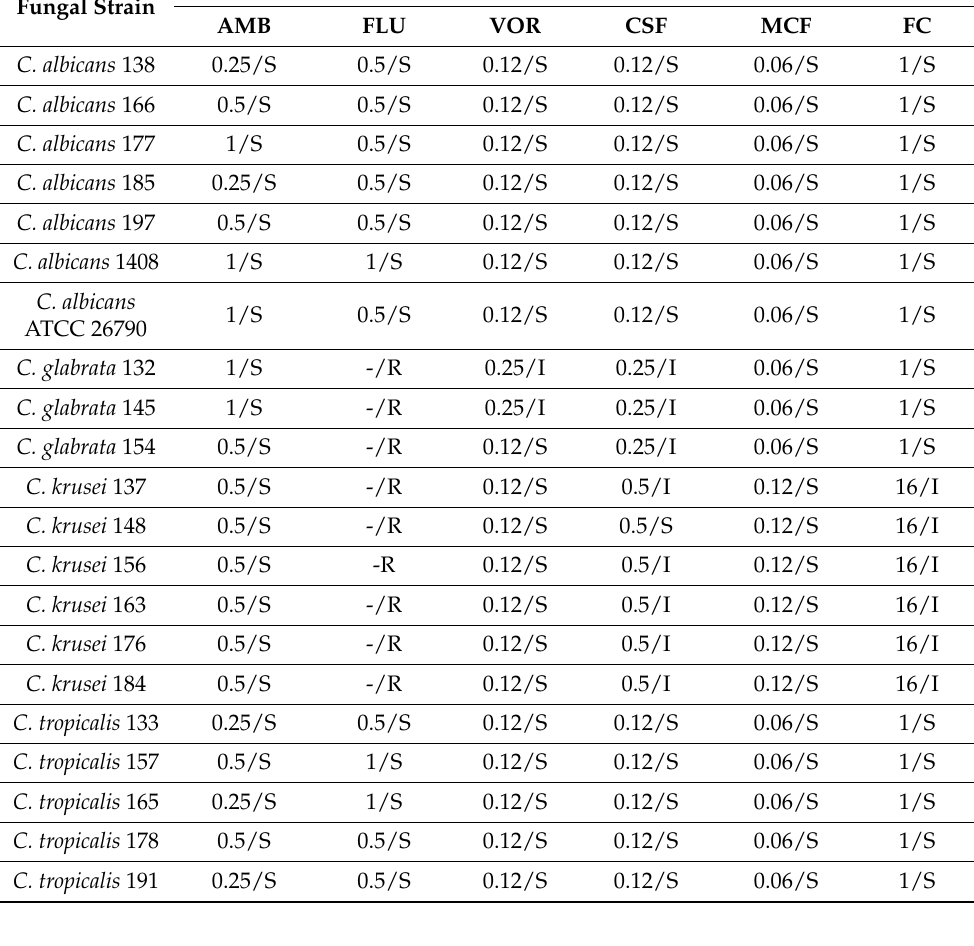
Table 1. Susceptibility of tested Candida isolates to conventional antimitotic agents. S—susceptible;